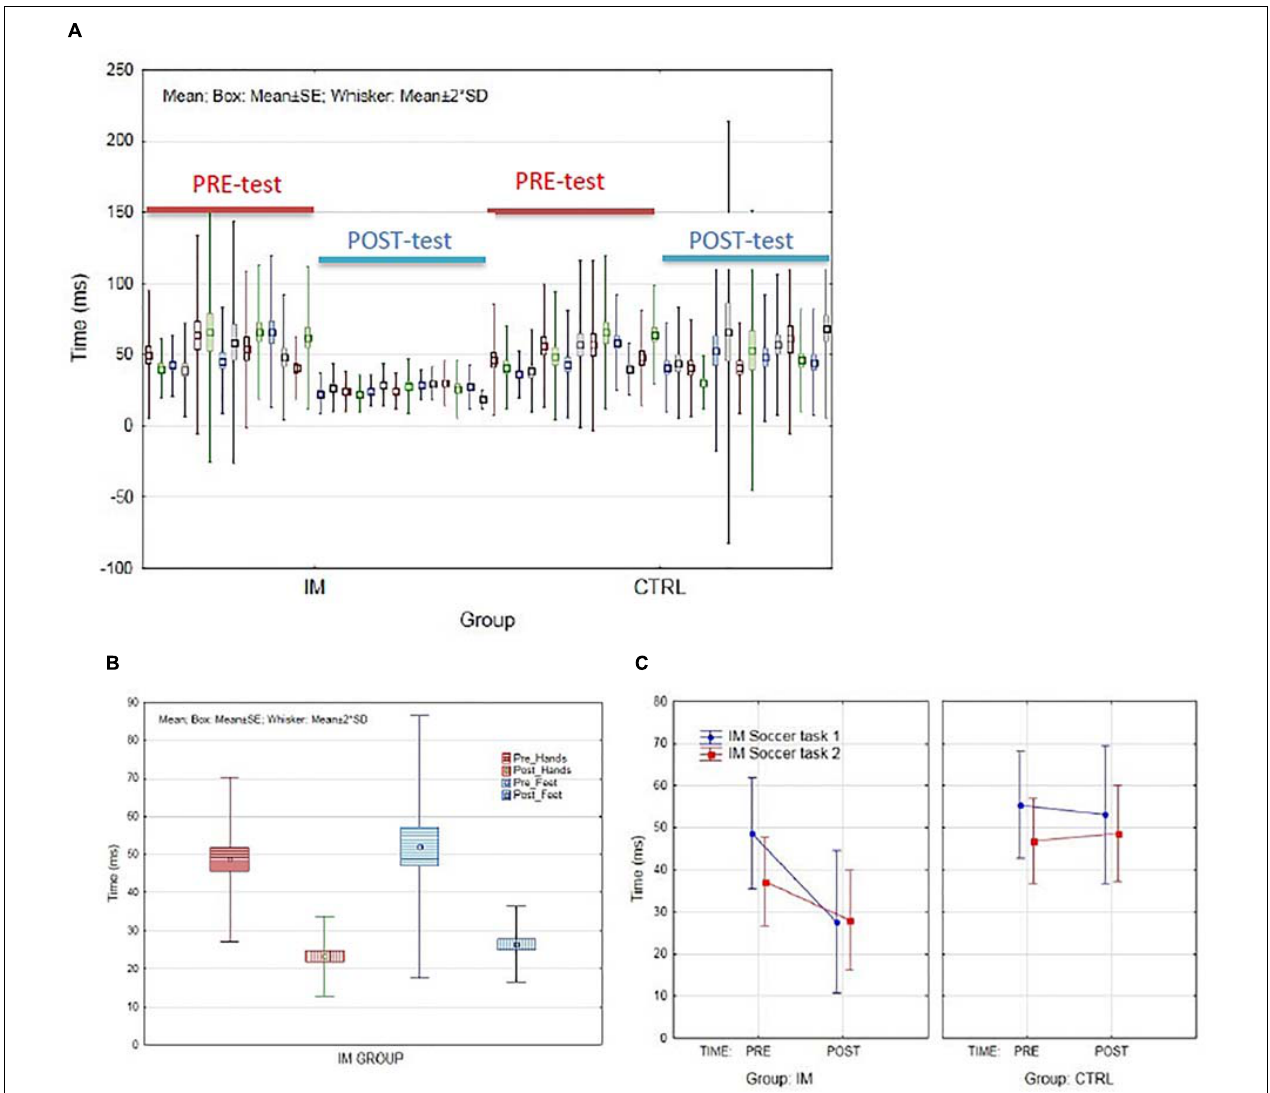
FIGURE 2 | The pre- and post-test mean response time in milliseconds from (A) all the fourteen standard IM timing tasks for the SMT group and the control group, respectively, and (B) the mean response time from the two IM categories including arms-hands (tasks 1–3, and 14), and legs-feet (tasks 4–9, 12, and 13) as an effect of tests for the SMT group only, and (C) the mean response time from the two soccer related tasks (1, stepping task including both feet, and 2, kicking task with the dominant foot) as a function of tests and groups.